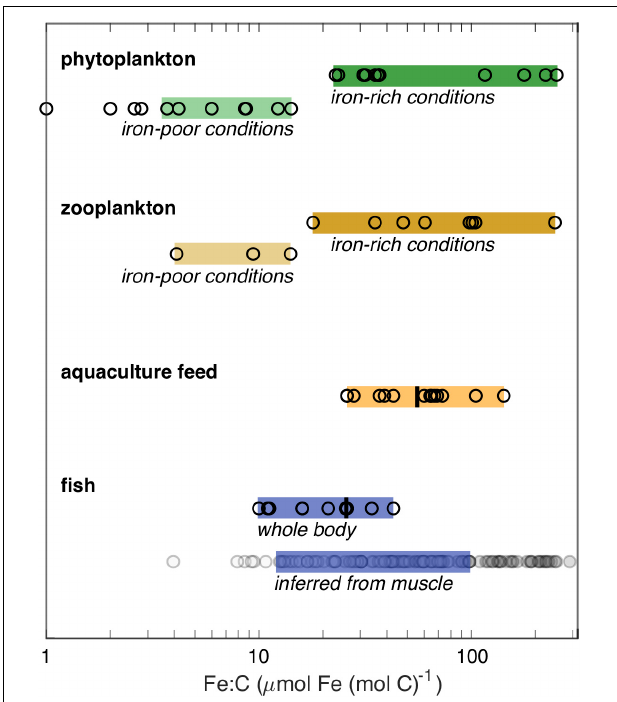
FIGURE 4 | Measured Fe:C molar concentration ratios from published sources (see Supplementary Materials ). The upper portion shows the Fe:C measured in plankton, differentiated by whether they were grown under iron-rich or iron-poor conditions. The very low phytoplankton values are not included within the colored-bar range as they were grown under an extreme iron limitation in culture. The lower portion shows measured adult fish Fe:C, using the mean of multiple measurements when available, and recommended Fe:C in feed for aquaculture of marine fish species, with vertical lines showing the mean values estimated by Prabhu et al. (2016). For the inferred whole-fish Fe:C, filled circles show upper (dark) and lower (pale) estimates assuming that muscle Fe:C is 14 and 45% of the whole-fish Fe:C, respectively; the blue bar indicates the most confident range, spanning from the upper estimate for the smallest measured value to the lower estimate for the largest measured